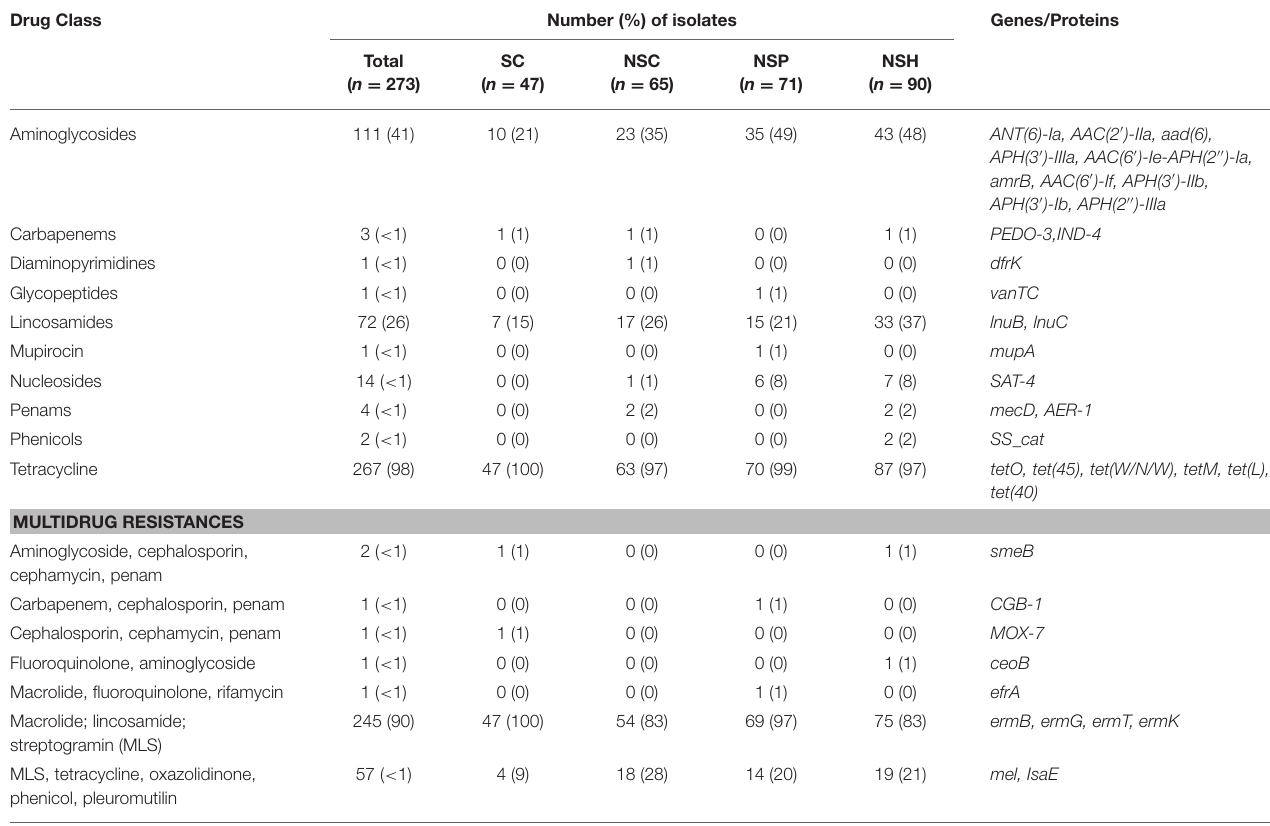
TABLE 4 | AMR genes detected in 273 S. suis isolates in SC, NSC, NSP, and NSH groups. Drug